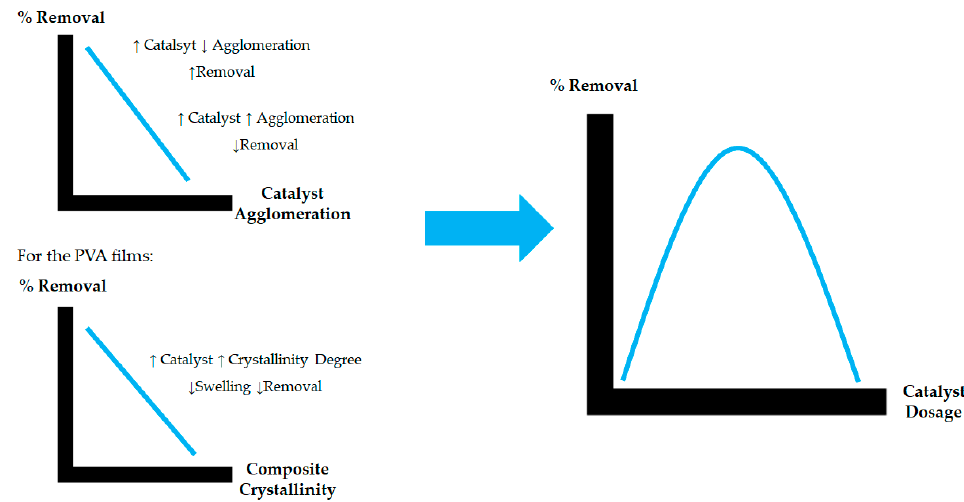
Figure 4. Effect of photocatalyst addition on pollutant removal.